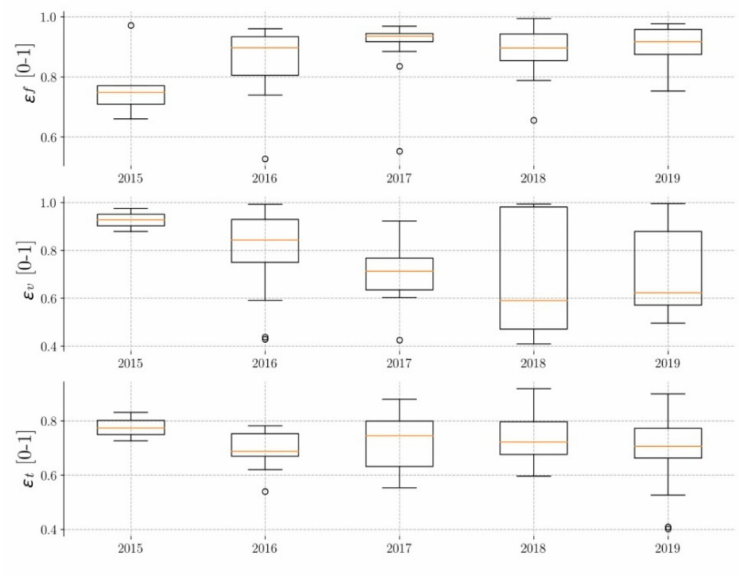
Figure 6. Evolution of pavement P1 e ffi ciency.